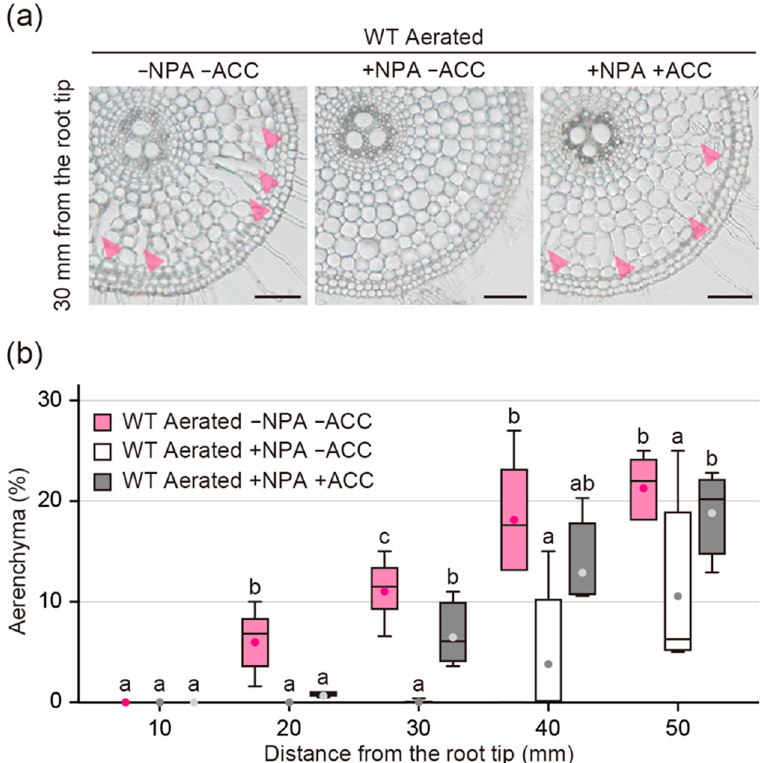
Figure 6. Aerenchyma formation under aerated conditions with or without N -1-naphthylphthalamic acid (NPA) or 1-aminocyclopropane-1-carboxylic acid (ACC) treatments. ( a ) Cross-sections at 30 mm from the tips of adventitious roots of the wild type (WT). Aerenchyma is indicated by magenta arrowheads. Bars = 100 µ m. ( b ) Percentages of aerenchyma in root cross-sectional area at 10, 20, 30, 40, and 50 mm. Twenty-day-old aerobically grown WT seedlings were further grown under aerated conditions without NPA and ACC, with 0.5 µ M NPA and without ACC or with 0.5 µ M NPA and 10 µ M ACC for 48 h. Di ff erent lowercase letters denote significant di ff erences among the conditions ( p < 0.05, one-way ANOVA followed by Tukey’s test for multiple comparisons). Boxplots show the median (horizontal lines), 25th to 75th percentiles (edges of the boxes), minimum to maximum (edges of the whiskers), and mean values (dots in the boxes) ( n = 4–6).